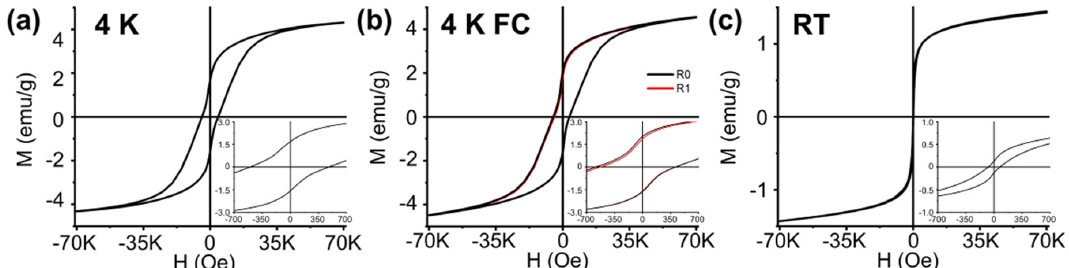
refers to the hysteresis recorded immediately after the first one; ( c ) Hysteresis recorded at RT.